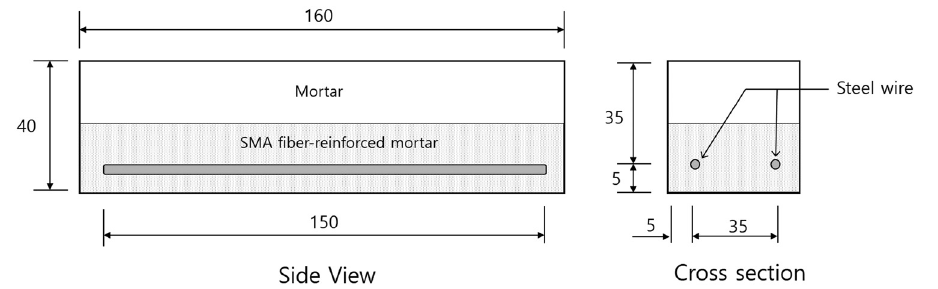
Figure 1: Geometry and cross section of a beam specimen ( units: mm )